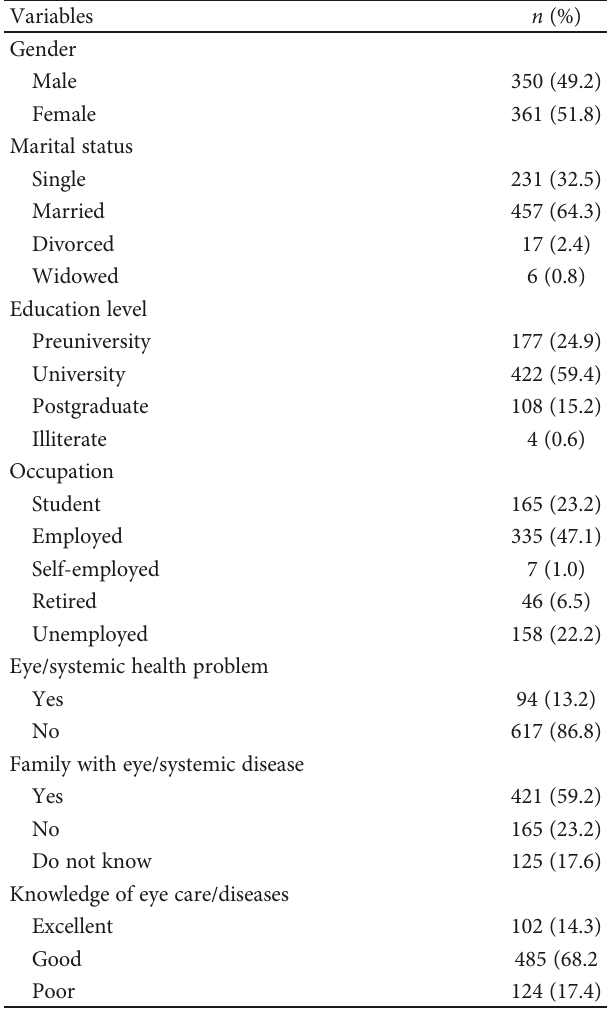
Table 1: Demographic information of the Saudi adults in Riyadh city